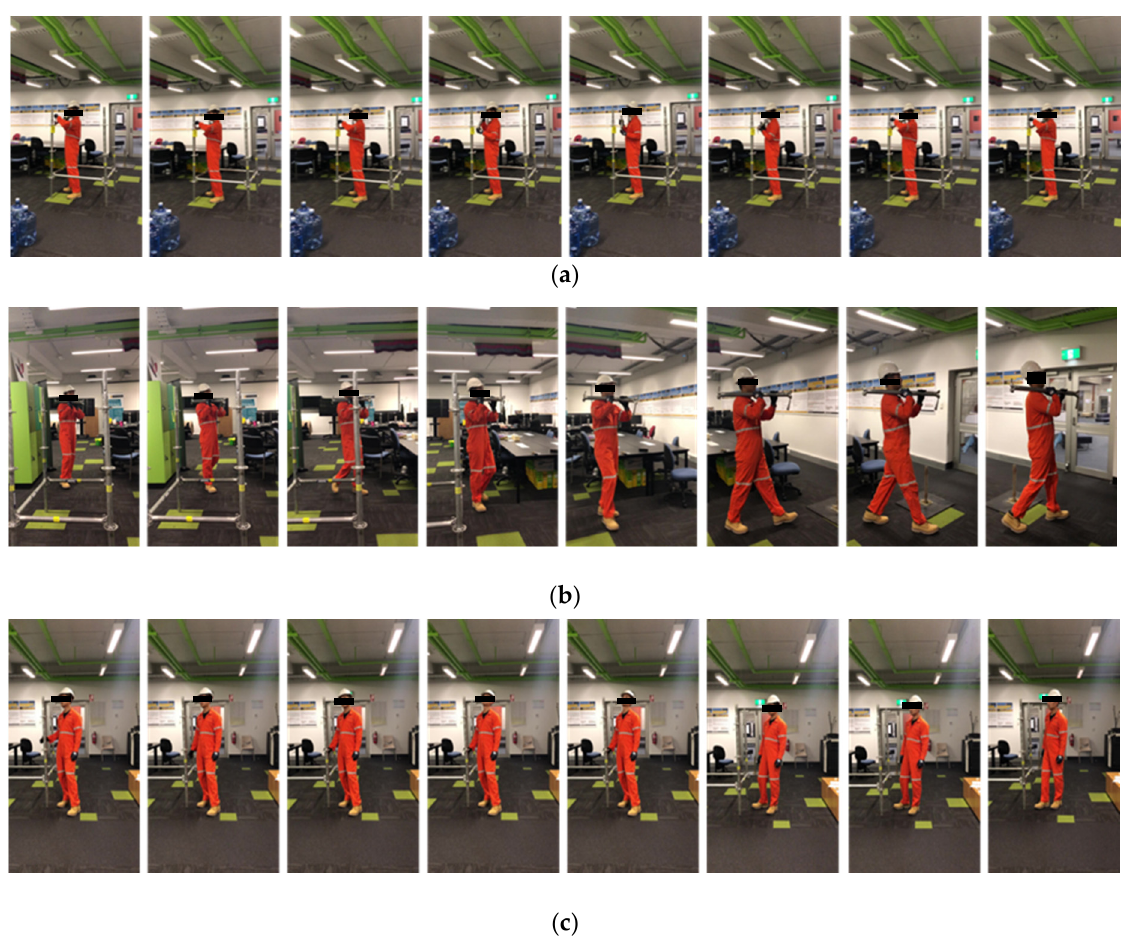
Figure 10. Video sequences of scaffolding activity: ( a ) scaffolding erecting; ( b ) transporting; ( c ) waiting or idling.